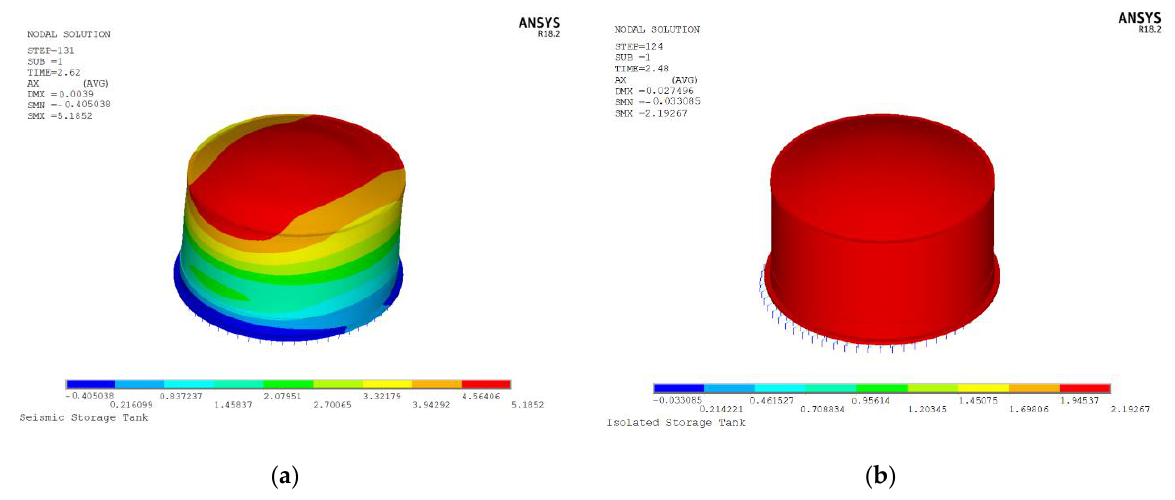
Figure 15. Acceleration cloud diagram of storage tank: ( a ) seismic storage tank; ( b ) isolation storage tank.